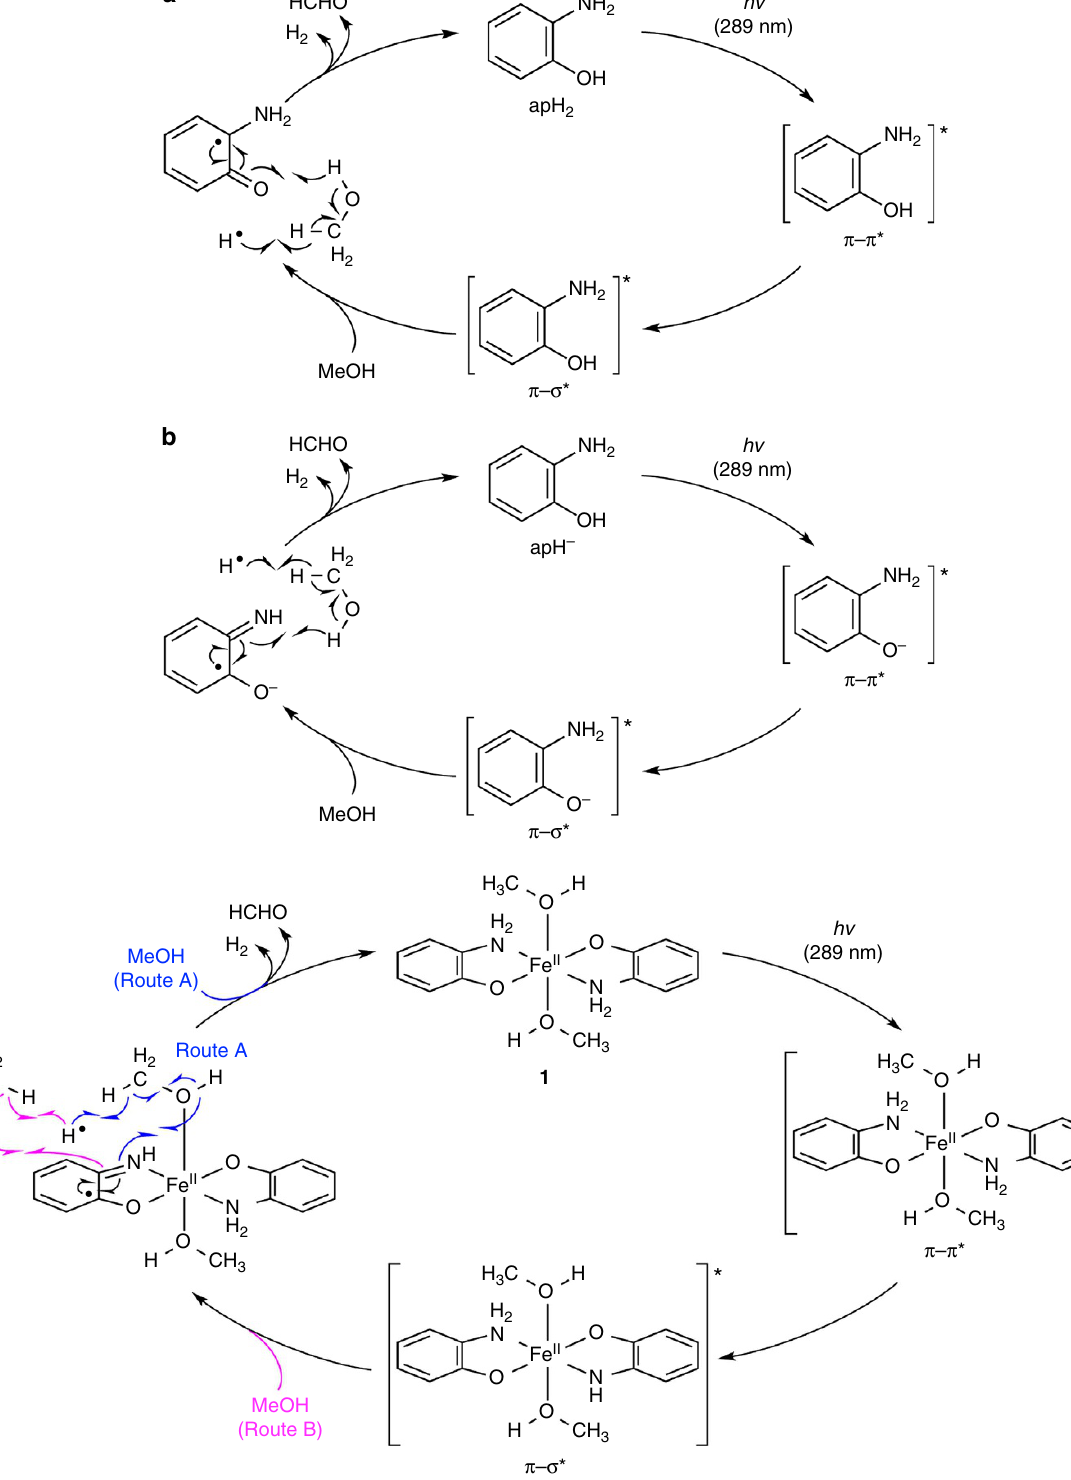
Figure 8 | Plausible PHER mechanisms. Reaction cycles catalysed by ( a ) apH 2 , ( b ) apH (cid:2) and ( c ) 1 upon irradiation at 289 ±